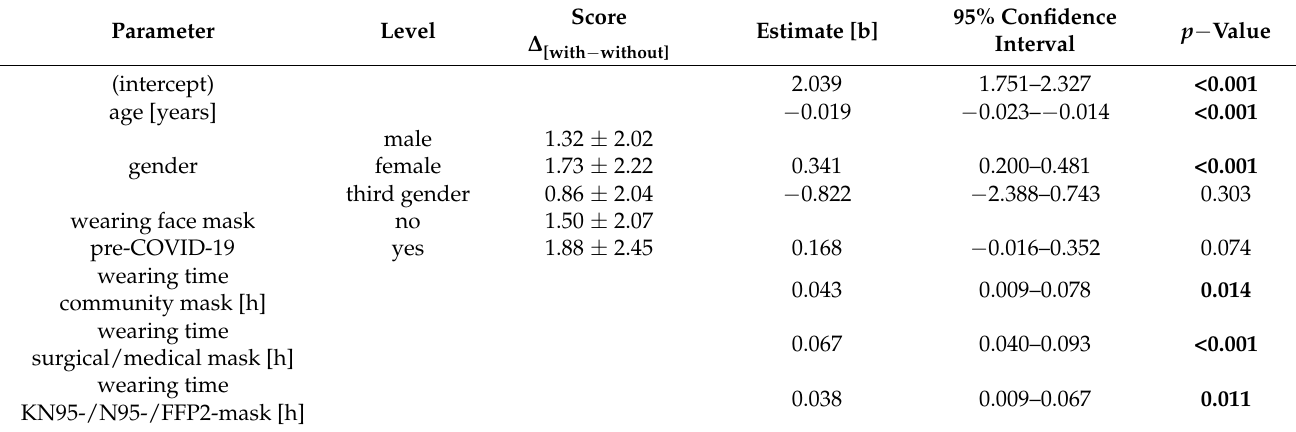
Table 3. Descriptive statistics of single parameters regarding the change in summated halitosis score (mean ± standard deviation) and effect estimates, 95% confidence intervals and p -values from multiple linear regression